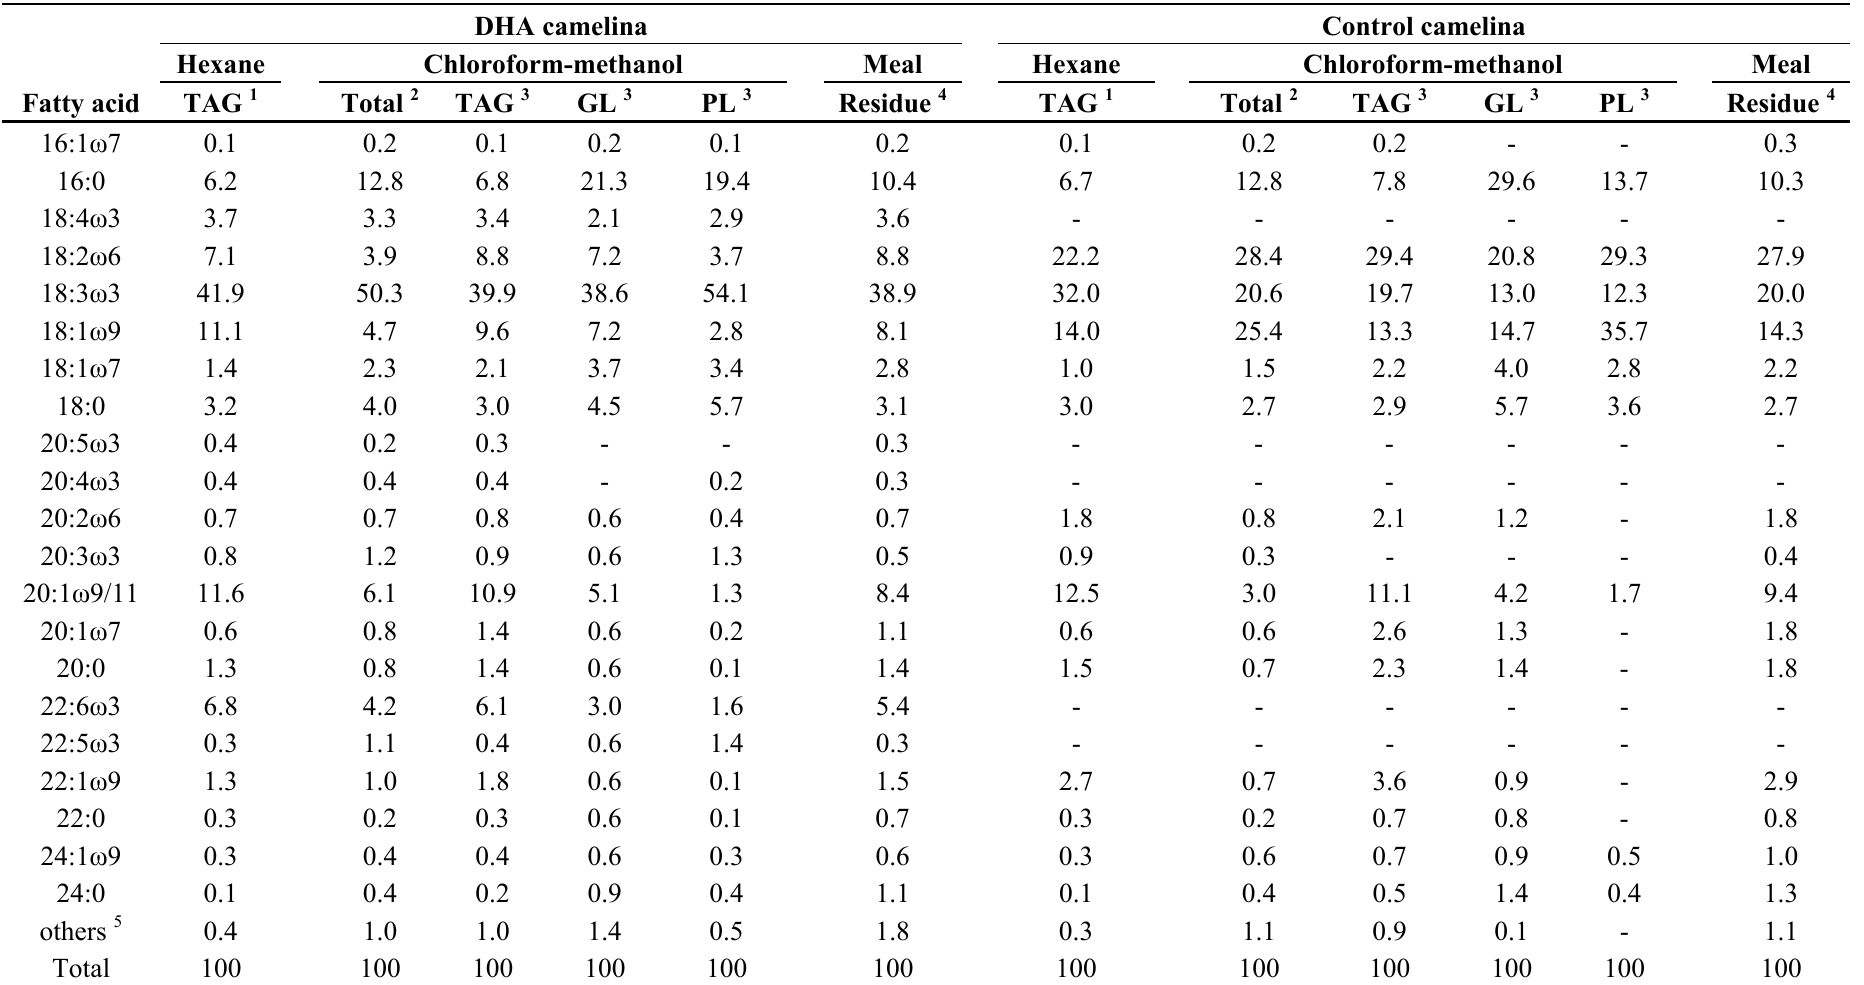
Table 4. Fatty acid composition (% of total fatty acids) of various lipid extracts and fractions of DHA- and control Camelina sativa . DHA camelina Control camelina Hexane Chloroform-methanol Meal Hexane Chloroform-methanol